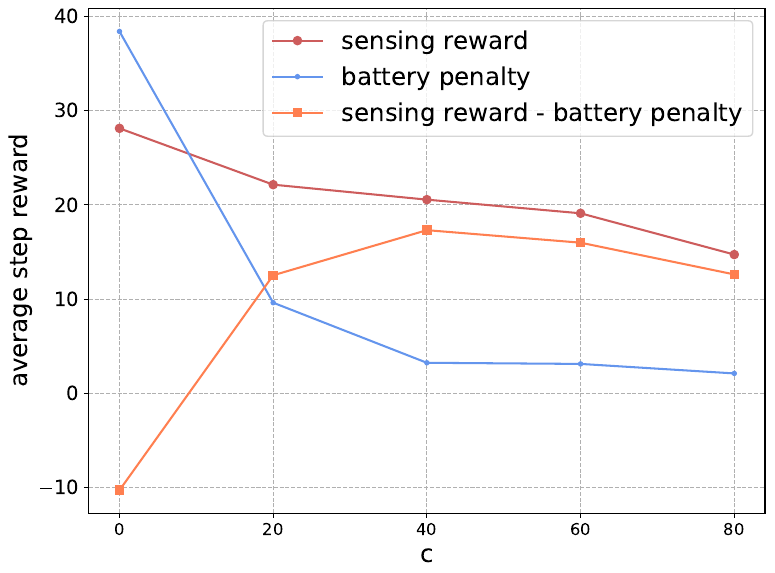
Figure 9. The average step reward (orange part), sensing reward (red part) and battery penalty (blue part) in the execution phase with respect to different values of c